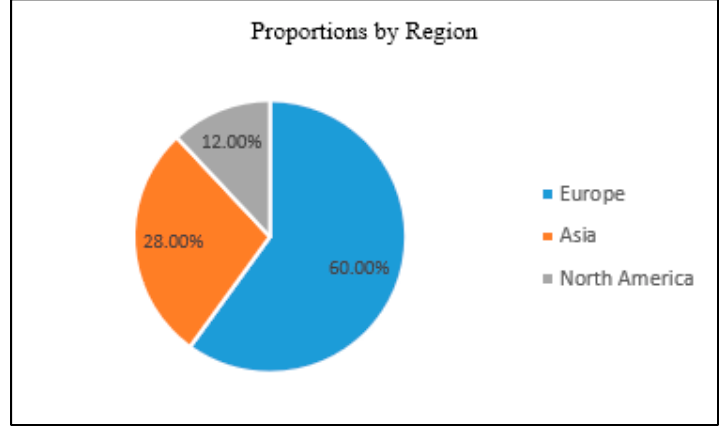
Figure 3. Proportion of research papers by region.